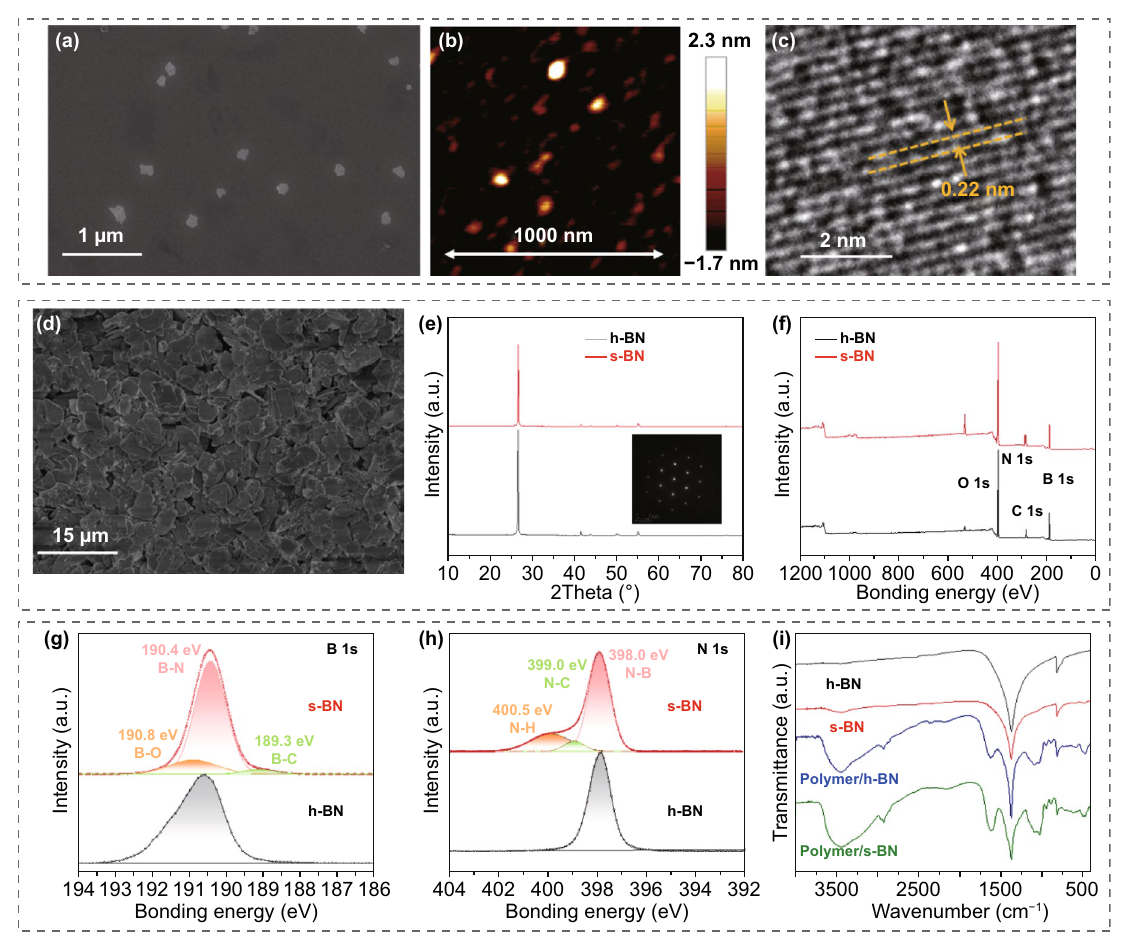
Fig. 2 Characterization of BNNCs, s-BN and the polymer/s-BN composite film. a SEM, b AFM and c HRTEM images of BNNCs. d SEM image of s-BN with lateral sizes of 10–15 μm. Structural evolution observed via e XRD and f–h XPS for h-BN and s-BN. The inset in e presents the SAED pattern of s-BN with a perfect hexagonal lattice. i FTIR spectrum evolution of h-BN, s-BN, polymer/h-BN and